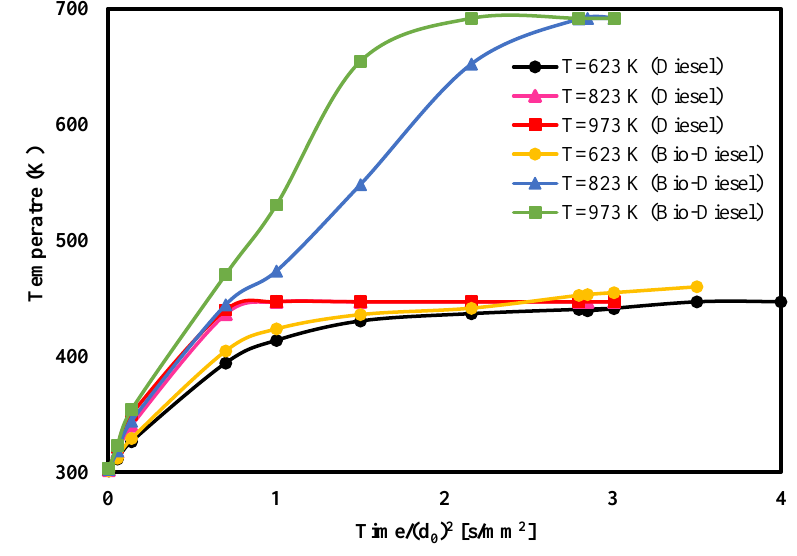
ff ect of ambient gas temperature on the evaporation of 25-micron Figure 7. Effect of ambient gas temperature on the evaporation of 25-micron droplet. Figure 7. E